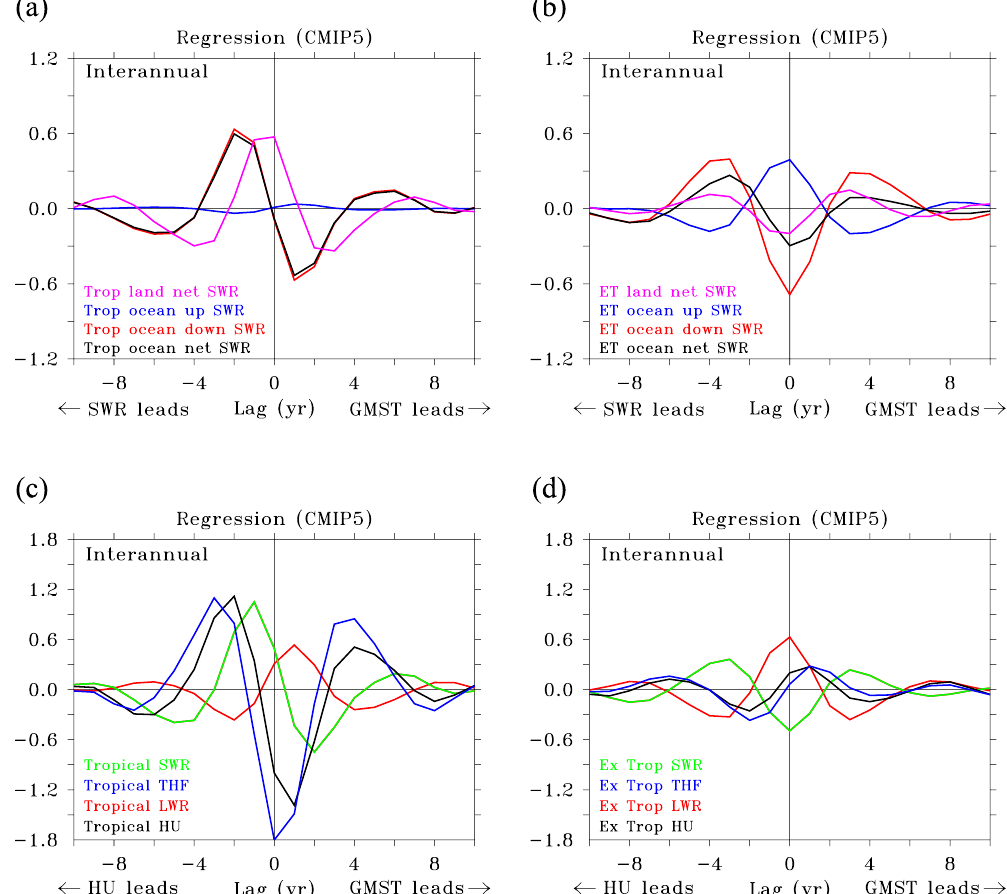
Figure 5. Relationship between GMST and HU/SWR in inter-annual variations for different areas. ( a – d ) Lagged regression ( a , b ) of net shortwave radiation (SWR) and of net heat uptake HU ( c , d ), against GMST. ( a , b ) SWR split between tropics (30°S and 30°N) and extra-tropics, ocean and land, and upward and downward shortwave radiation such that the black and purple lines in both panels sum to the green line in Fig. 1; HU split between tropics and extra-tropics such that both panels sum to Fig. 1. ( c , d ) Regression values are in W m − 2 K − 1